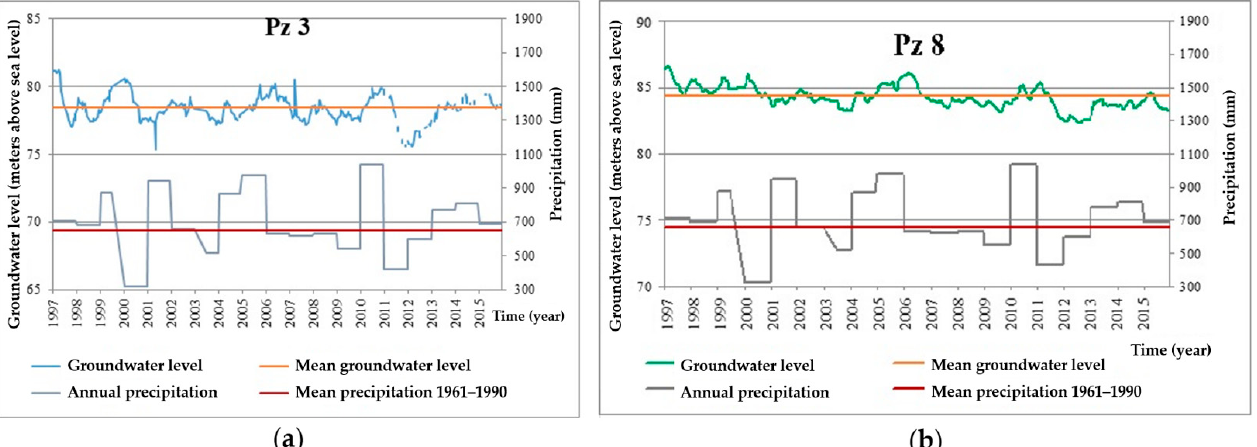
Table 2. Comparison of hydrological parameters for Pz 3 and Pz 8 in the years 2000–2001,